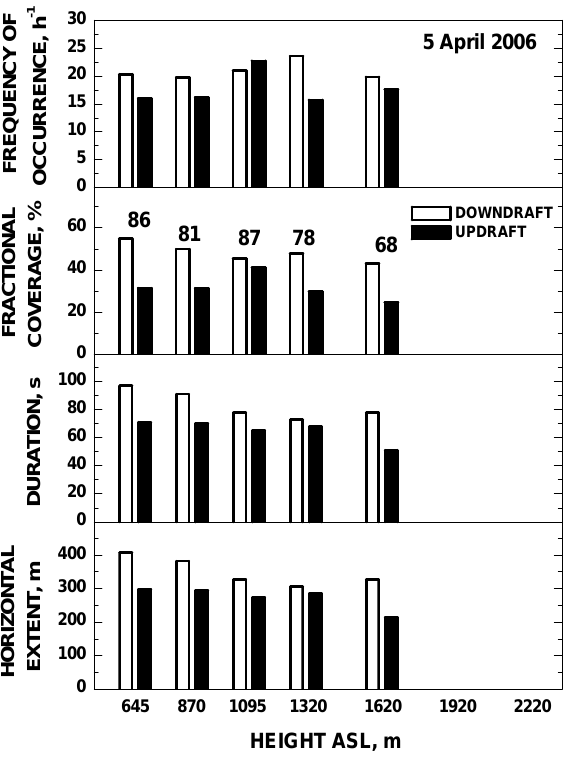
Fig. 7. Same as Fig. 6, except for 5 May 2006, 09:15–18:14LT